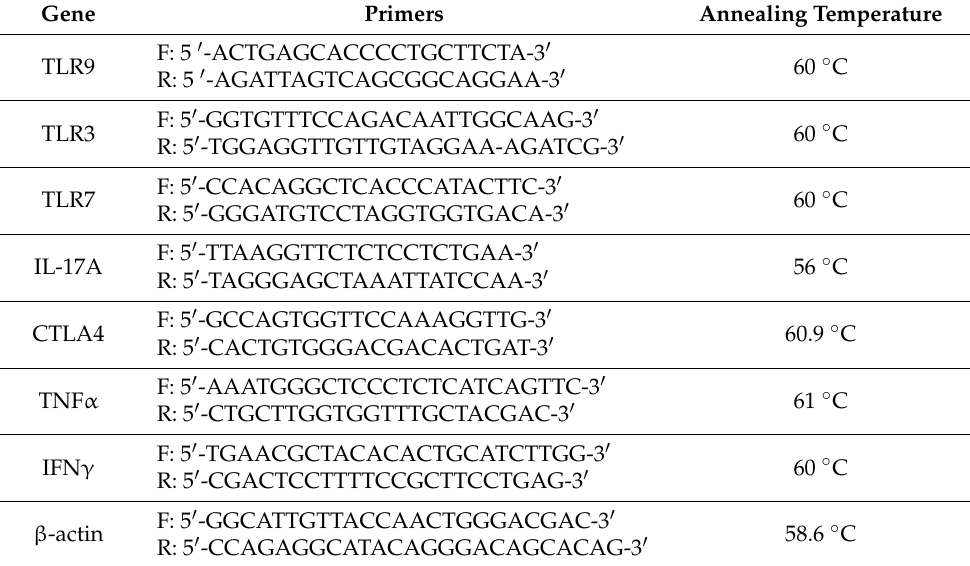
Table 1. Primers and annealing temperatures used for real time